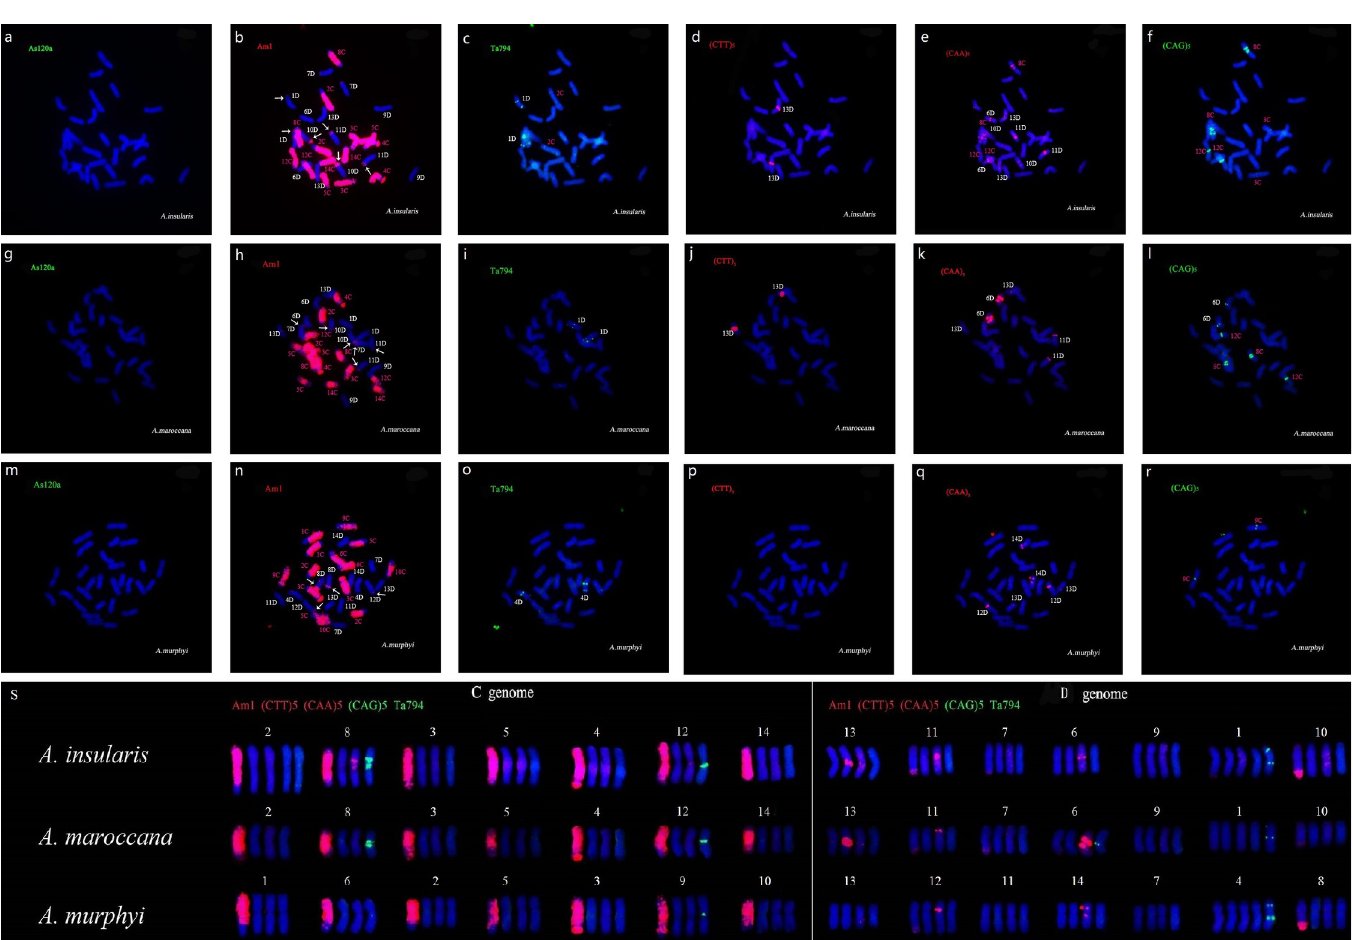
Fig 2. Karyotypes of the tetraploid species A . insularis (a-f), A . maroccana (g-l), and A . murphyi (m-r) after sequential FISH analysis. The chromosome assignments were based on work of Fominaya et al. [35]. The probes included FAM-As120a (green), TAMRA-Am1 (red), FAM-Ta794 (green), TAMRA-(TTC) 5 (red), TAMRA-(AAC) 5 (red), and FAM-(CAG) 5 (green). (s) Karyotype of single metaphase chromosomes of these species. The white arrows indicate the intergenomic translocations.